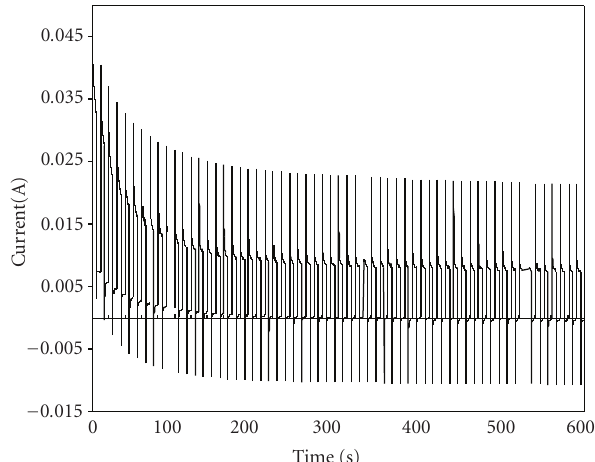
Figure 3: Current response throughout pulse voltammetry exper- iment for the 0.05 M FeCl 3 . 6H 2 O/KOH (pH = 3.0) system with carbon fibers brush as working